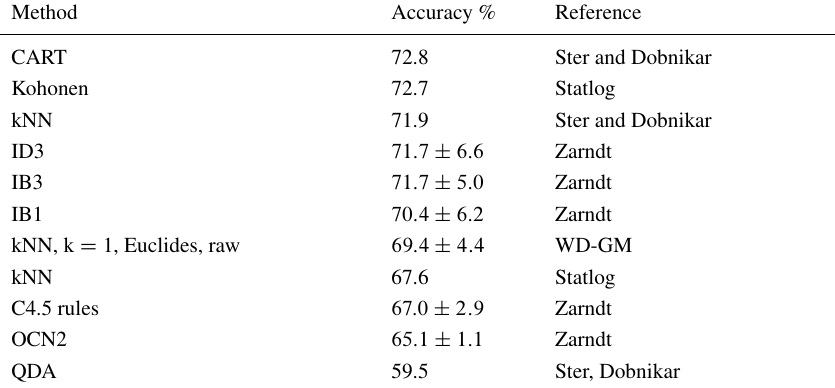
Table 3. The classification accuracy of the proposed model compared with different machine learning methods on Pima Indian Diabetes Dataset